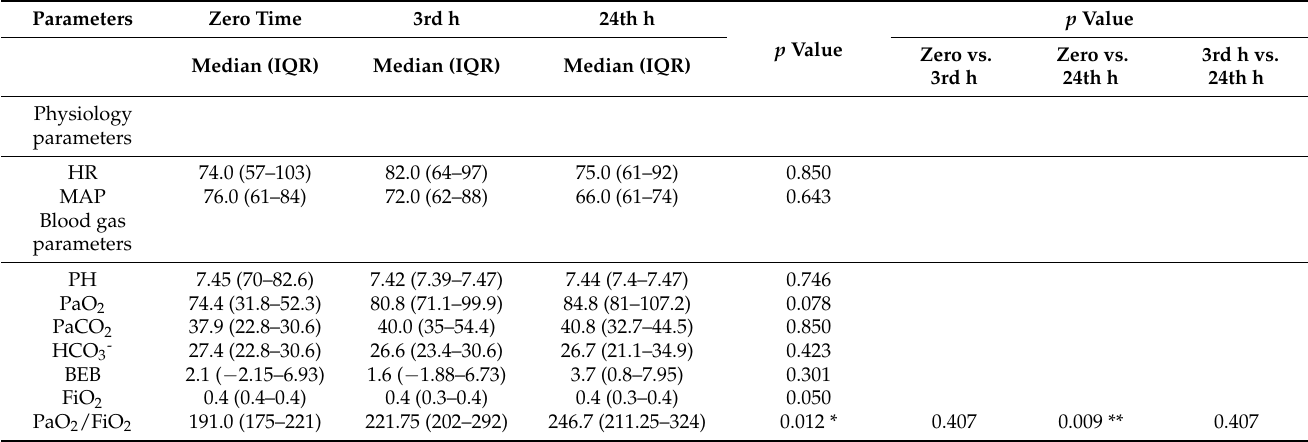
Table 3. Blood gas parameters and PaO 2 /FiO 2 at different time